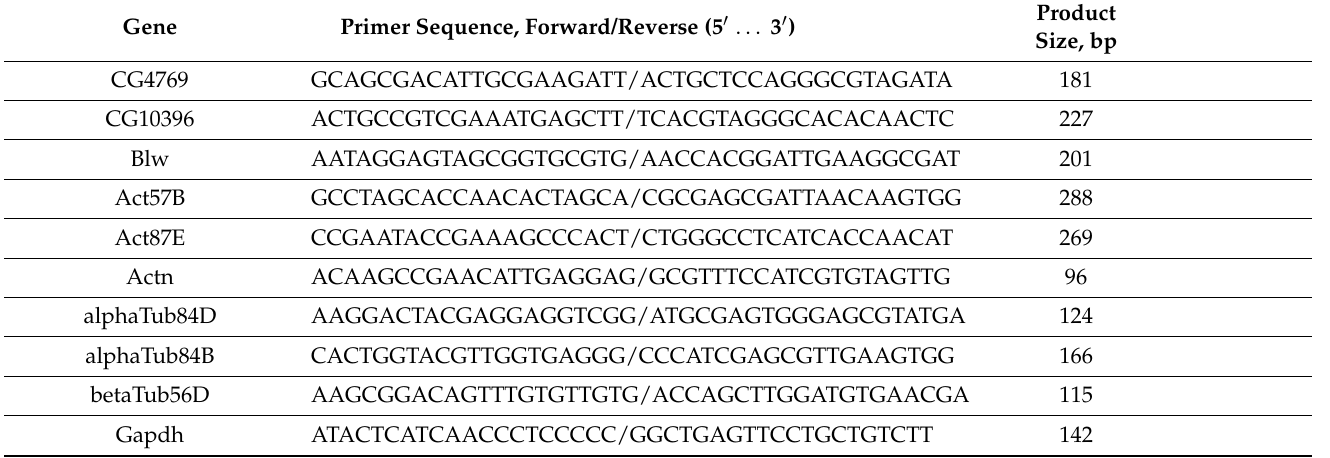
Table 2. Primer sequence and product